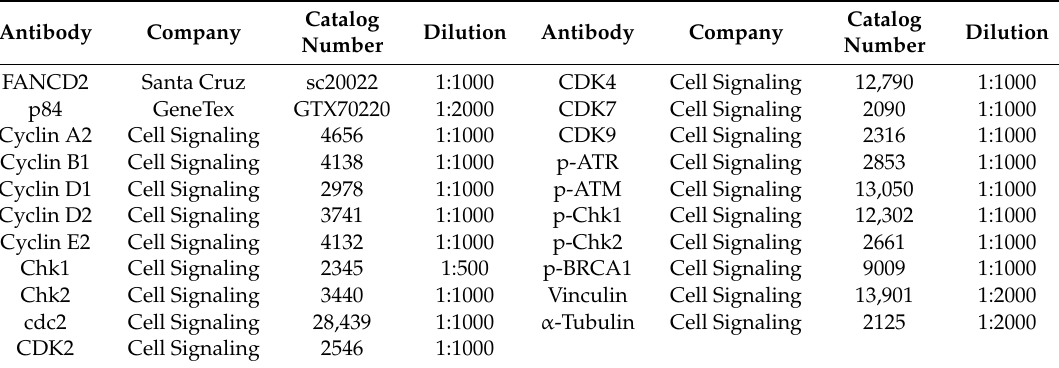
Table 1. Antibody information Used for Western